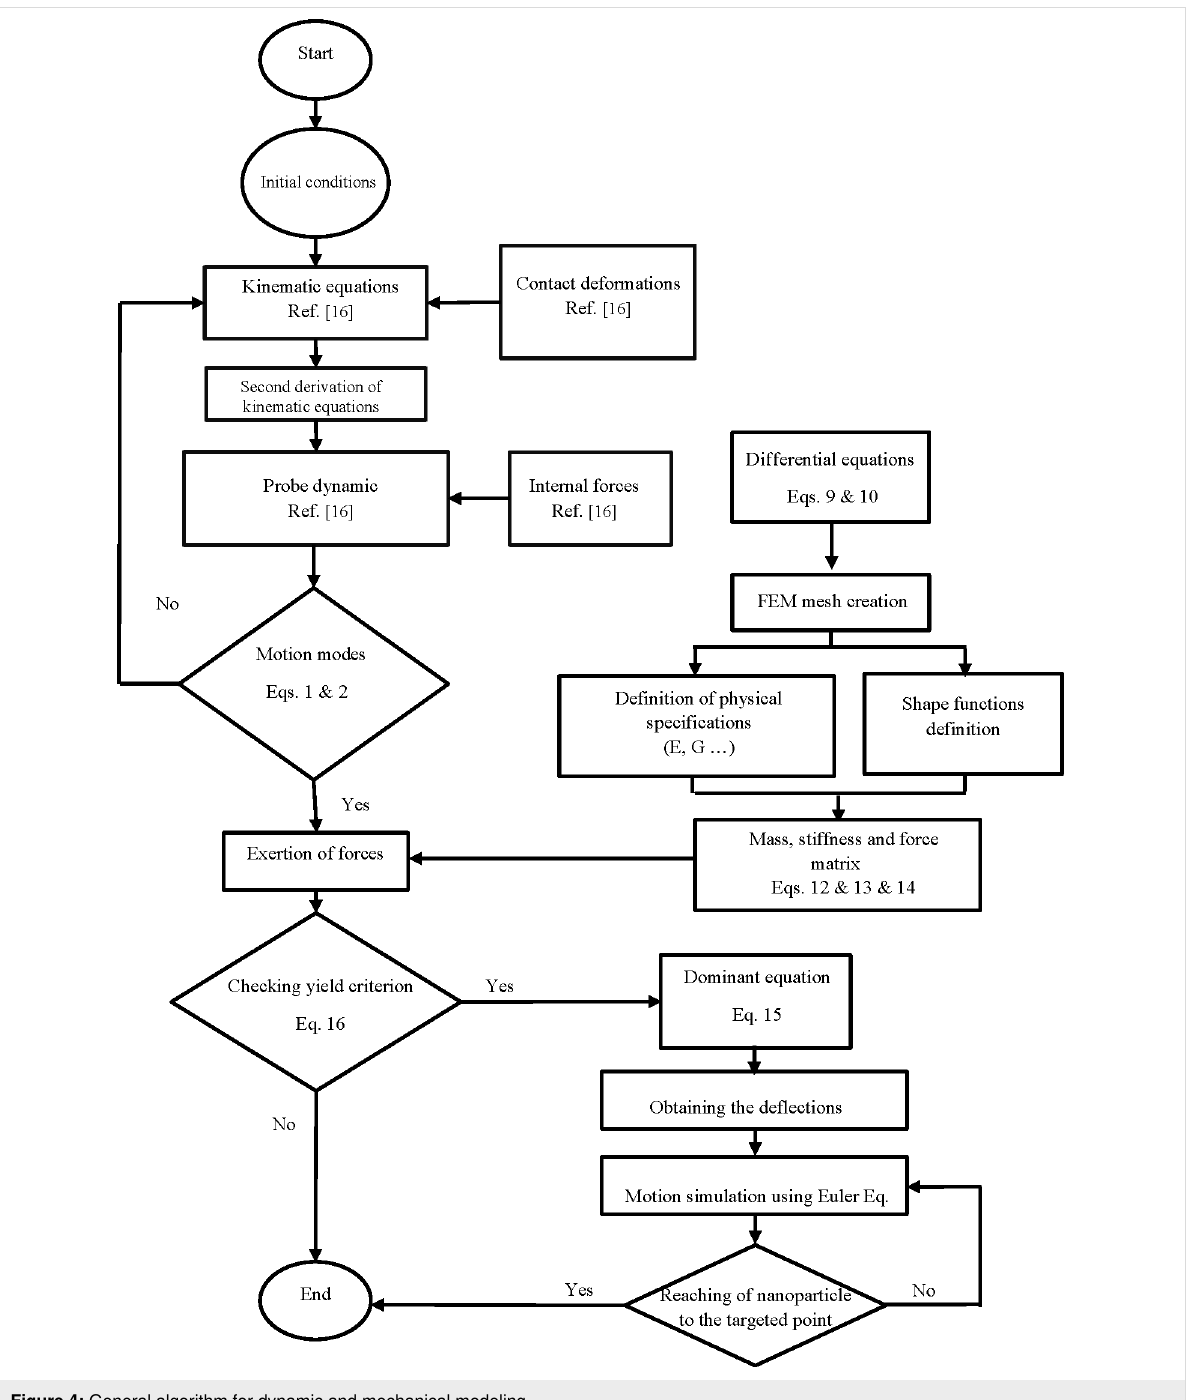
Figure 4: General algorithm for dynamic and mechanical modeling.